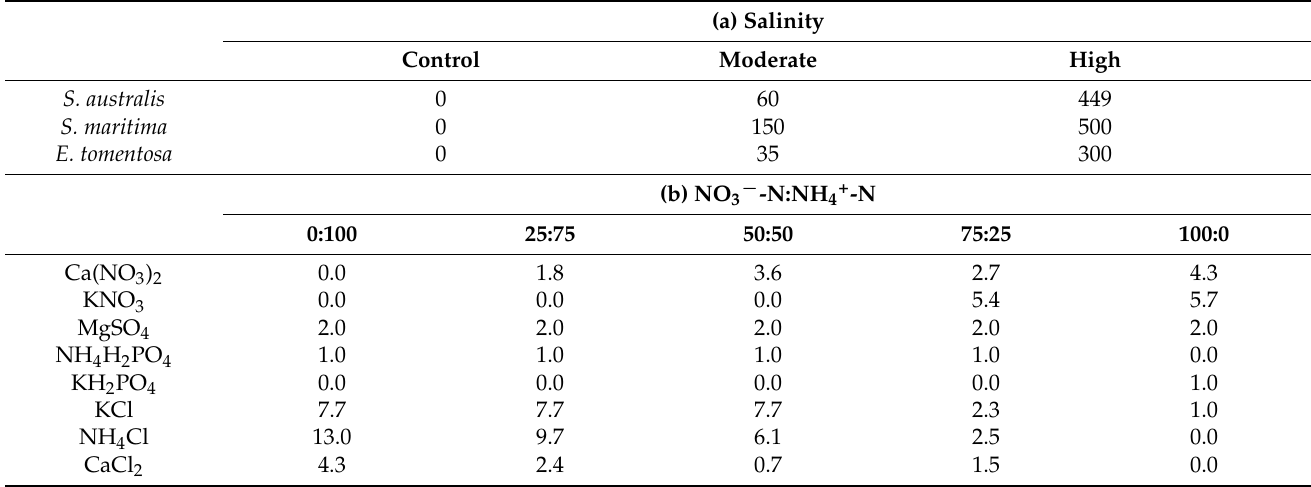
Table 1. Salinity and NO 3 − -N:NH 4+ -N ratio used in combined irrigations ( a ) Specific salinities (mM NaCl equivalent) for Salsola australis , Suaeda maritima and Enchylaena tomentosa . ( b ) Macronutrient compositions (mM) in the five N-ratios (NO 3 − -N:NH 4+ -N). (a)